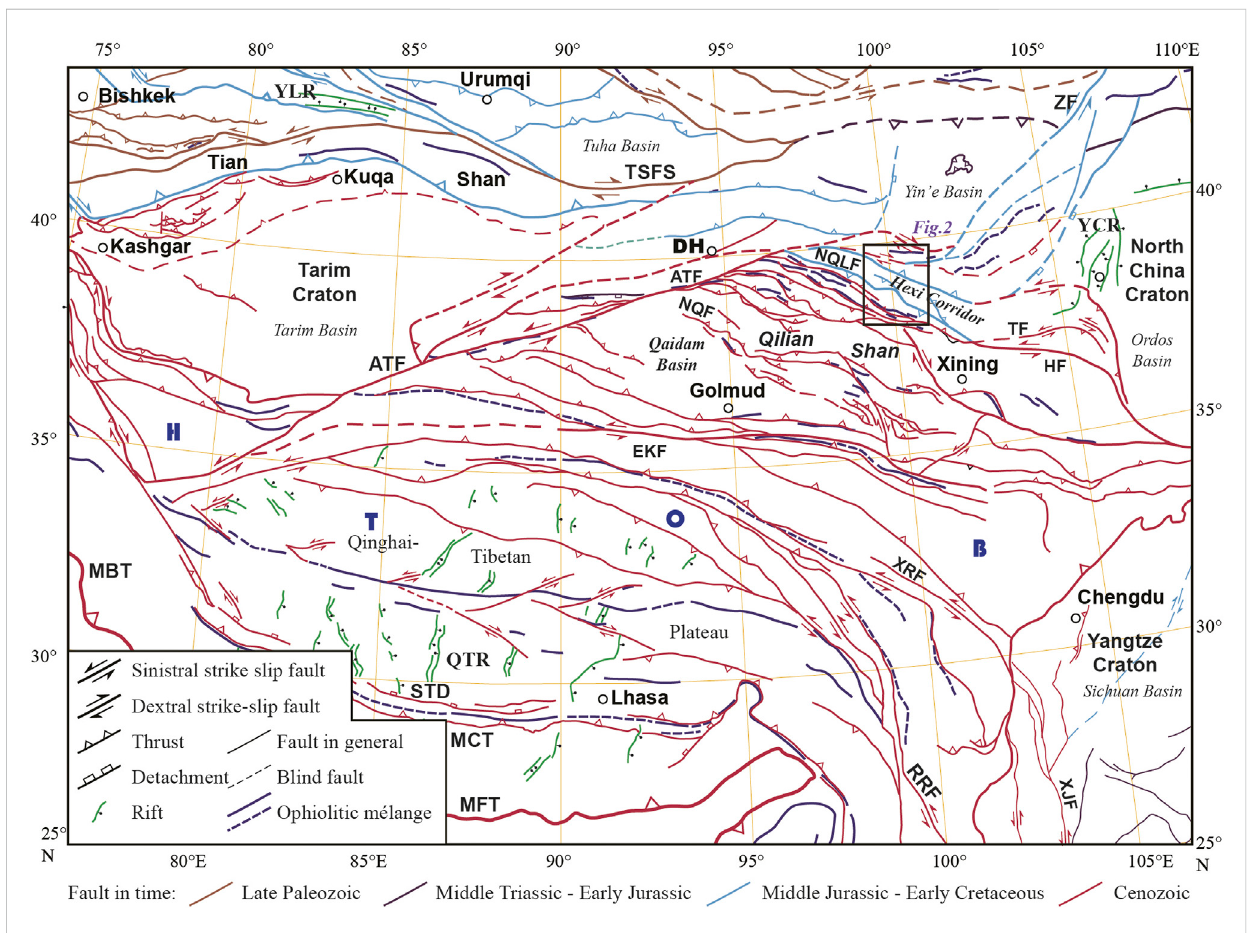
FIGURE 1 Simpli fi ed fault system of the Tibetan Plateau, modi fi ed from Yin et al. (2008a), Yin et al. (2008b), Chen et al. (2019a), and Chen et al. (2022a). HTOB, Himalaya – Tibetan Orogenic Belt. Faults: ATF, Altyn Tagh; NQLF, North Qilian; NQF, North Qaidam; HF, Haiyuan; TF, Tianjingshan; ZF, Zuunbayan; RRF, Red River; XRF, Xianshui River; EKF, East Kunlun. TSFS, Tianshan strike – slip fault system. STD, South Tibet Detachment; MCT, Main Central Thrust; MBT, MainBoundaryThrust;MFT,MainFrontalThrust.Riftsystems:YCR,Yinchuan;YLR,Yili;QTR,Qinghai – Tibetan.DH,CityofDunhuang.Therectangle shows the location of Figure